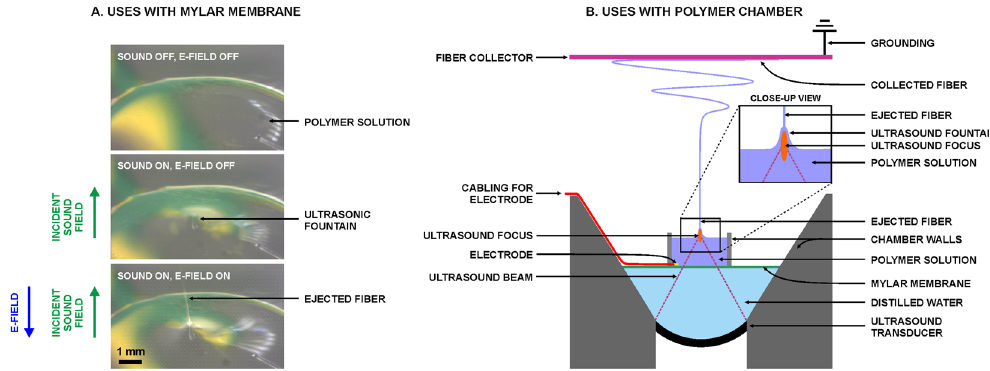
Figure 1. ( A ) The applied high-intensity ultrasound generated an acoustic fountain, when a polymer droplet was placed on a 0.2-mm thick mylar membrane (acoustically conducting, but electrically isolating), while focusing the beam through water at the polymer-air interface. When the polymer was charged using an electrode (from − 5 kV to − 15 kV) and an electrically grounded target was placed above the fountain, a liquid jet was observed at the top of the ultrasonic fountain. ( B ) The method described in ( A ) was developed into a USES system, which was employed for systematic investigation of ultrasonic fiber-topography control using an − 11.3 kV electrode voltage and 15 cm polymer to target